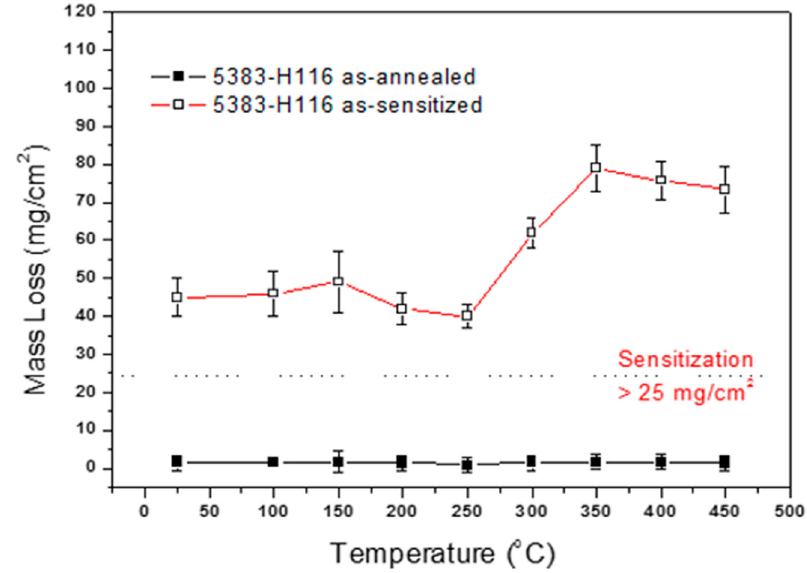
Figure 5. The 5383-H116 NAMLT test results after different heat treatment temperatures and sensitization treatment.